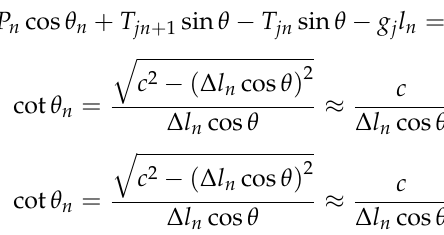
Figure 1. Stress analysis of the dropper offset.